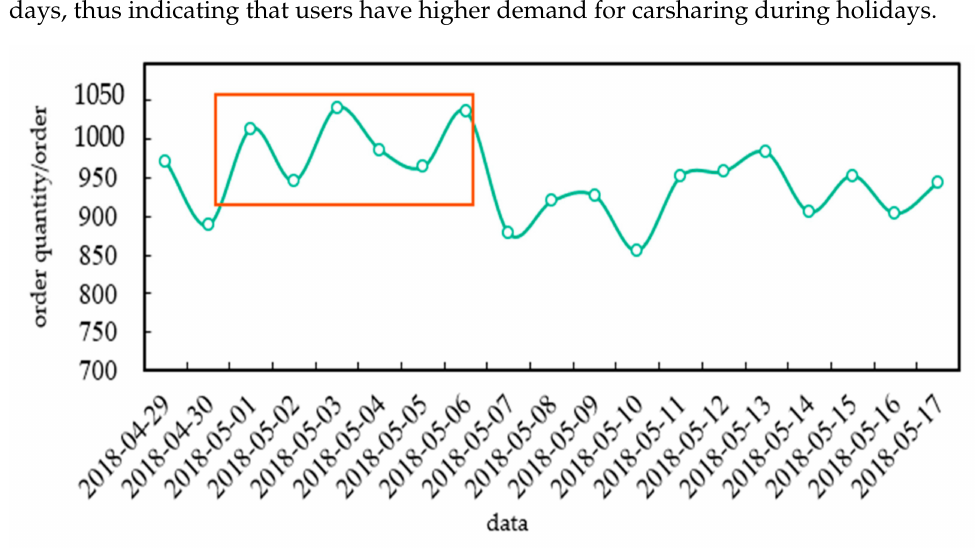
Figure 1. Users’ holiday travel